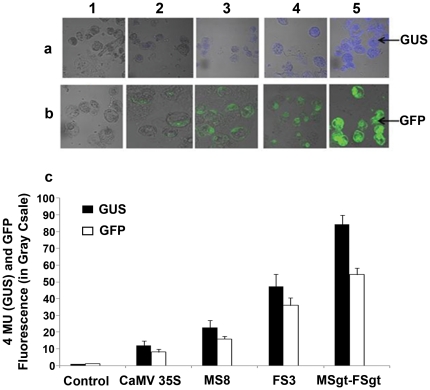
Fluorescence detection and transient assay of GUS (as 4-MU fluorescence) and GFP using a confocal laser scanning microscope (CLSM) for parental and hybrid promoters in tobacco protoplasts.(a) GUS activity as 4-MU fluorescence recorded in confocal microscope as described in methods for the promoter-GUS constructs: 1, pUCPMA (empty vector control, with no GUS); 2, pUCPMAGUS (with CaMV35S promoter) 3, pMS8GUS (with MS8 promoter [22]); 4, pFS3GUS (with FS3 promoter [23]) and 5, pUPMSgt-FSgtGUS (recombinant promoter). (b) GFP fluorescence recorded in confocal microscope as described in methods for the promoter-GFP constructs: 1, pUCPMA (empty vector control, with no GFP); 2, pUCPMAGFP (with CaMV35S promoter); 3, pMS8GFP (with MS8 promoter); 4, pFS3GFP (with FS3 promoter); and 5, pUPMSgt-FSgtGFP (hybrid promoter). (c) Transient assay of 4-MU fluorescence (for GUS) and GFP using CLSM for parental and hybrid promoters in tobacco protoplasts, fluorescence intensities for GUS and GFP were measured as described in methods and presented in a bar diagram as average value ± SD of two independent experiments, each performed in triplicate, for the GUS and GFP constructs as described in panel a and b: empty vector with no GUS or GFP (Control), CaMV35S, MS8, FS3 and MSgt-FSgt promoter constructs. (CaMV35S: Cauliflower mosaic virus; MS8: Mirabilis mosaic virus sub-genomic transcript promoter; FS3: Figwort mosaic virus sub-genomic transcript promoter; MSgt-FSgt: the hybrid promoter).